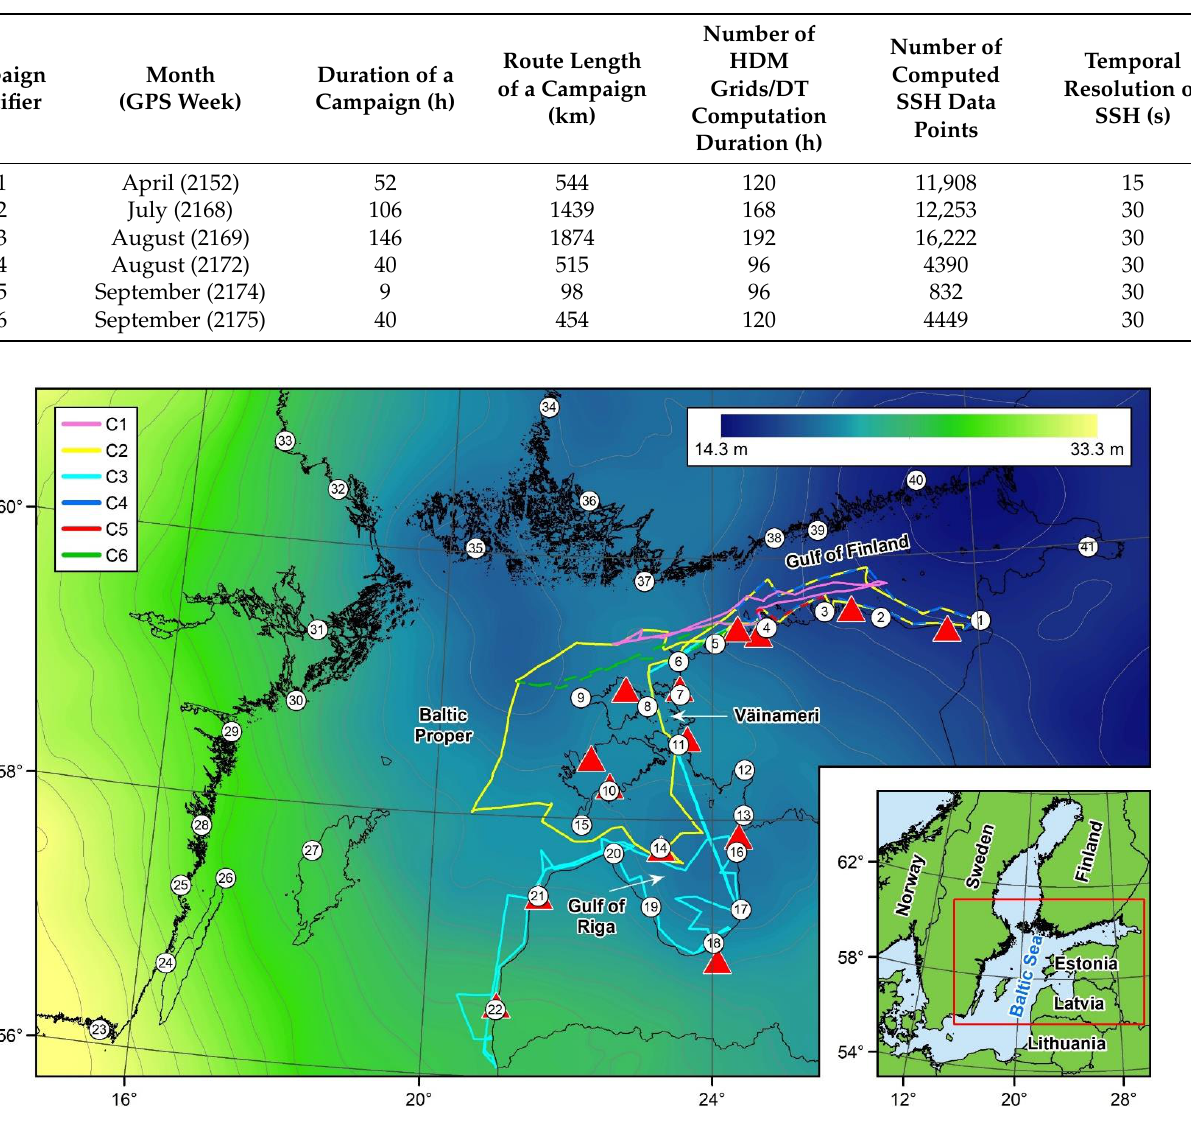
Table 1. General information about the conducted marine survey campaigns.